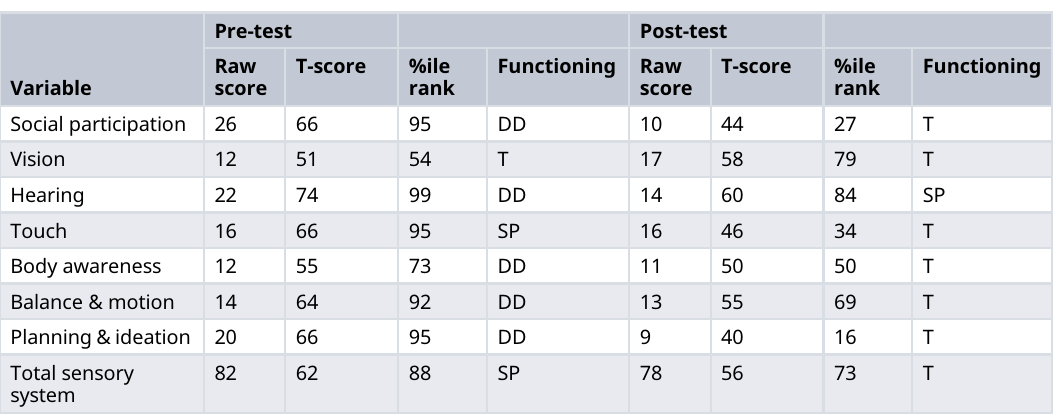
Table 3. Pre and post intervention SPM-P home form scale